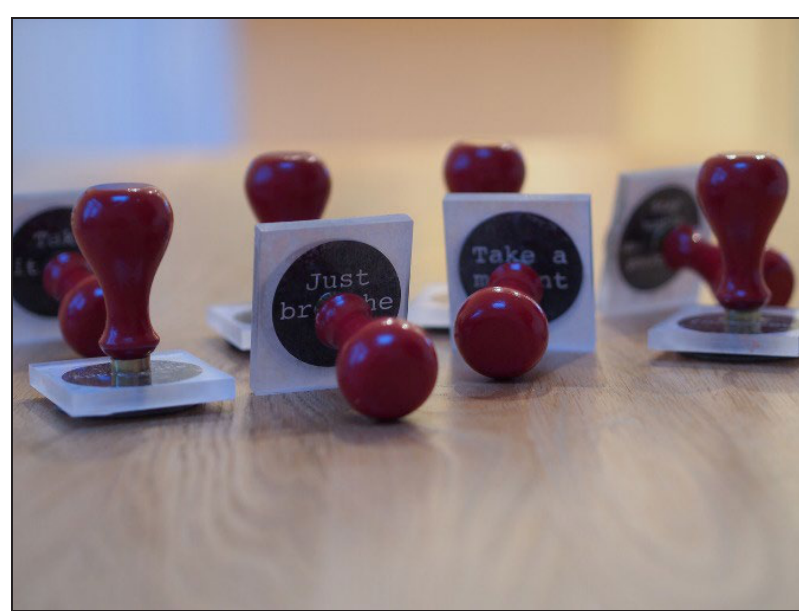
Figure 7: Davina Drummond & Yara El-Sherbini, Take a Moment . South London Gal- lery,